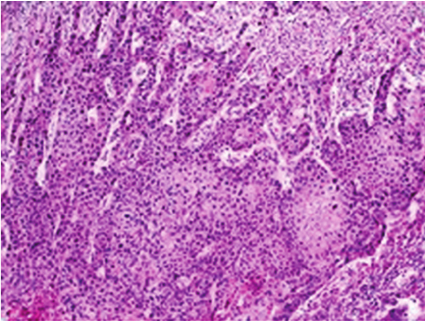
Figure 2: Squamous cell carcinoma, moderately differentiated (H&E × 200).